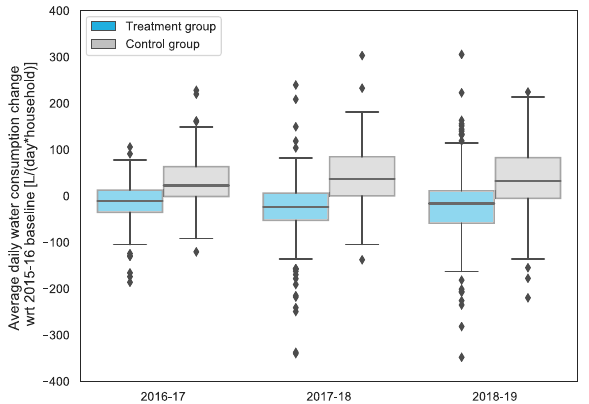
Fig. 2 Average daily household water consumption change distribution. Average daily water consumption changes in liters/ day are evaluated for each household in the treatment group (blue boxes) and in the control group (gray boxes). Short-term, medium- term, and long-term water consumption changes are evaluated with respect to pre-treatment average consumption levels observed in the baseline period June 1st, 2015 – April 30th, 2016. The line in the middle of each box represents the median value, boxes mark the fi rst and third quartile. The length of box whiskers is equal to 1.5 times the interquartile range. Diamond markers are